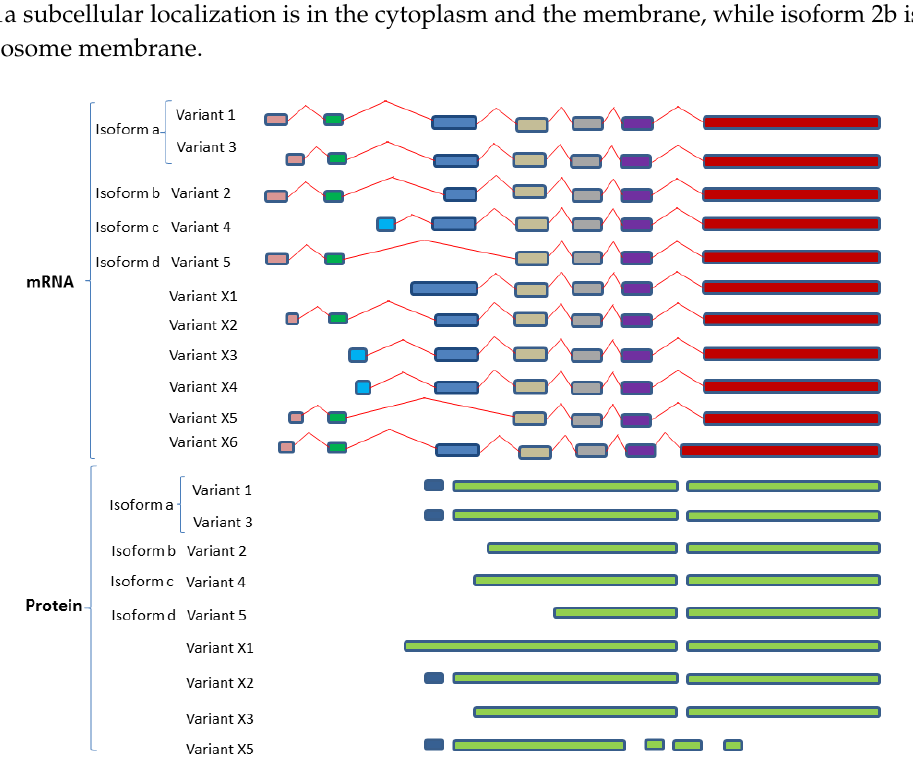
Figure 4. Variant splicing and dicing of human SphK2 isoforms. Schematic diagram of SphK2 variant isoforms based on mRNA and protein sequences acquired from GenBank. Colored boxes are representative of different RNA fragments or protein fragments, same color boxes are originated from the same origin of DNA sequences and are identical/similar sequences. The various described isoforms are derived from the expression of alternatively splicing SphK2 transcripts. Four protein isoforms have been identified for SphK2 and these express five SphK2 transcript variants. Human SphK2 isoform a (SphK2a/SphK-L) and SphK2 isoform b (SphK1b/SphK2-S) have been confirmed at the protein level. SphK2c and SphK2d protein translation has not been identified in humans to date. Variants X1-X5 were derived by automated computational analysis using gene prediction methods (Gnomon). Uniporter IDs are reported for variants SphK2 d, X5 and X6. All SphK2 sequences were aligned using Clustal Omega (V1.2.4) multiple sequence alignment (Available online: